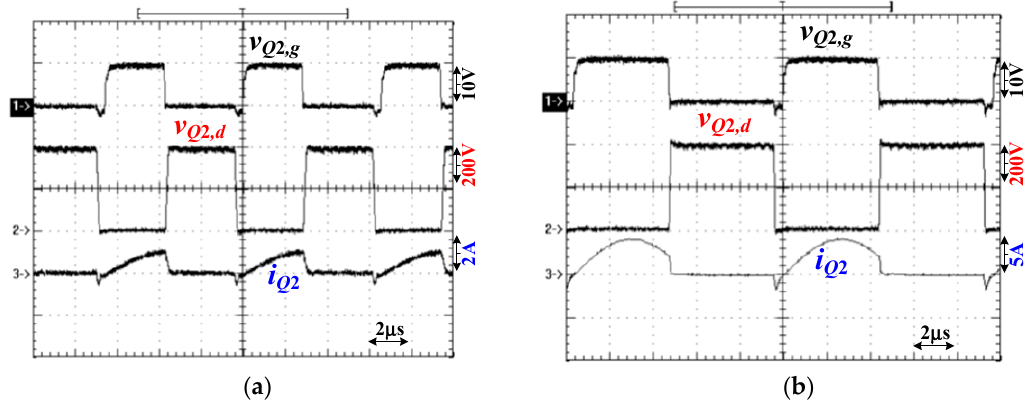
Figure 6. Test results of switch Q 2 under V 1 = 400 V with ( a ) 96 W (20%) output and ( b ) 480 W (100%) output.